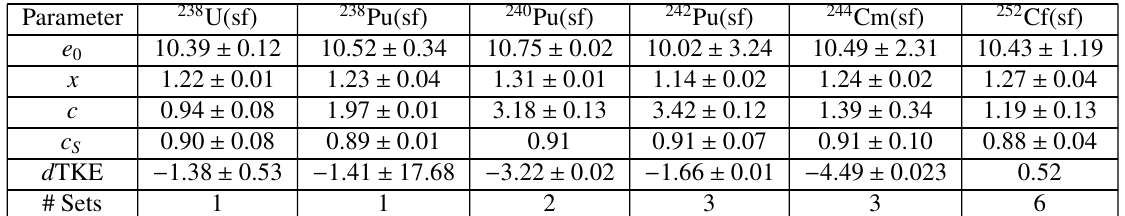
Table 1. Results of the optimization for all spontaneously fissioning isotopes which are modeled by FREYA . The best fit values of the five parameters and their associated variances are given for each isotope. In addition, the number of data sets and evaluations used for each isotope are indicated. The evaluations of Ref. [10], available for all isotopes, provides multiple observables: the neutron multiplicity distribution P ( ν ) and its first three moments: ν , ν 2 and ν 3 . From Ref.